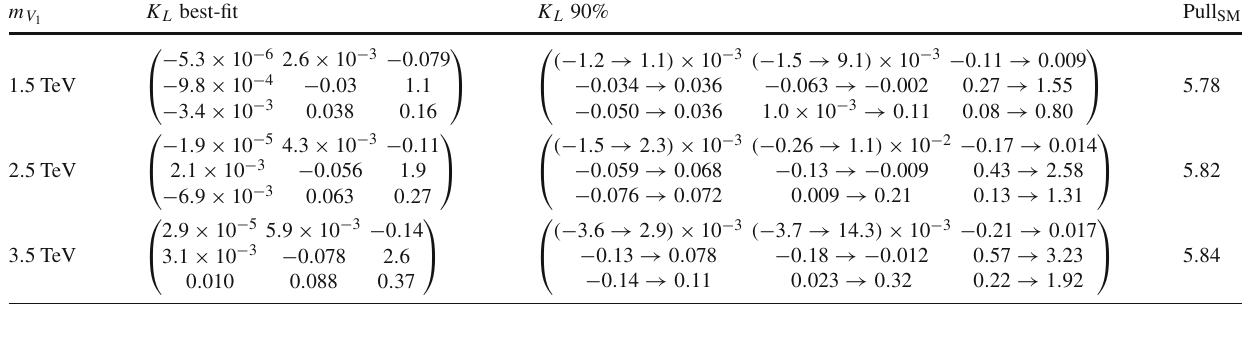
Table 4 Results of the fits including the current experimental bounds on CR (μ − e , Au ) and BR ( K L → e ± μ ∓ ) in the likelihood: best fit points and symmetric 90% ranges (see Appendix A for details) of K ij m V 1